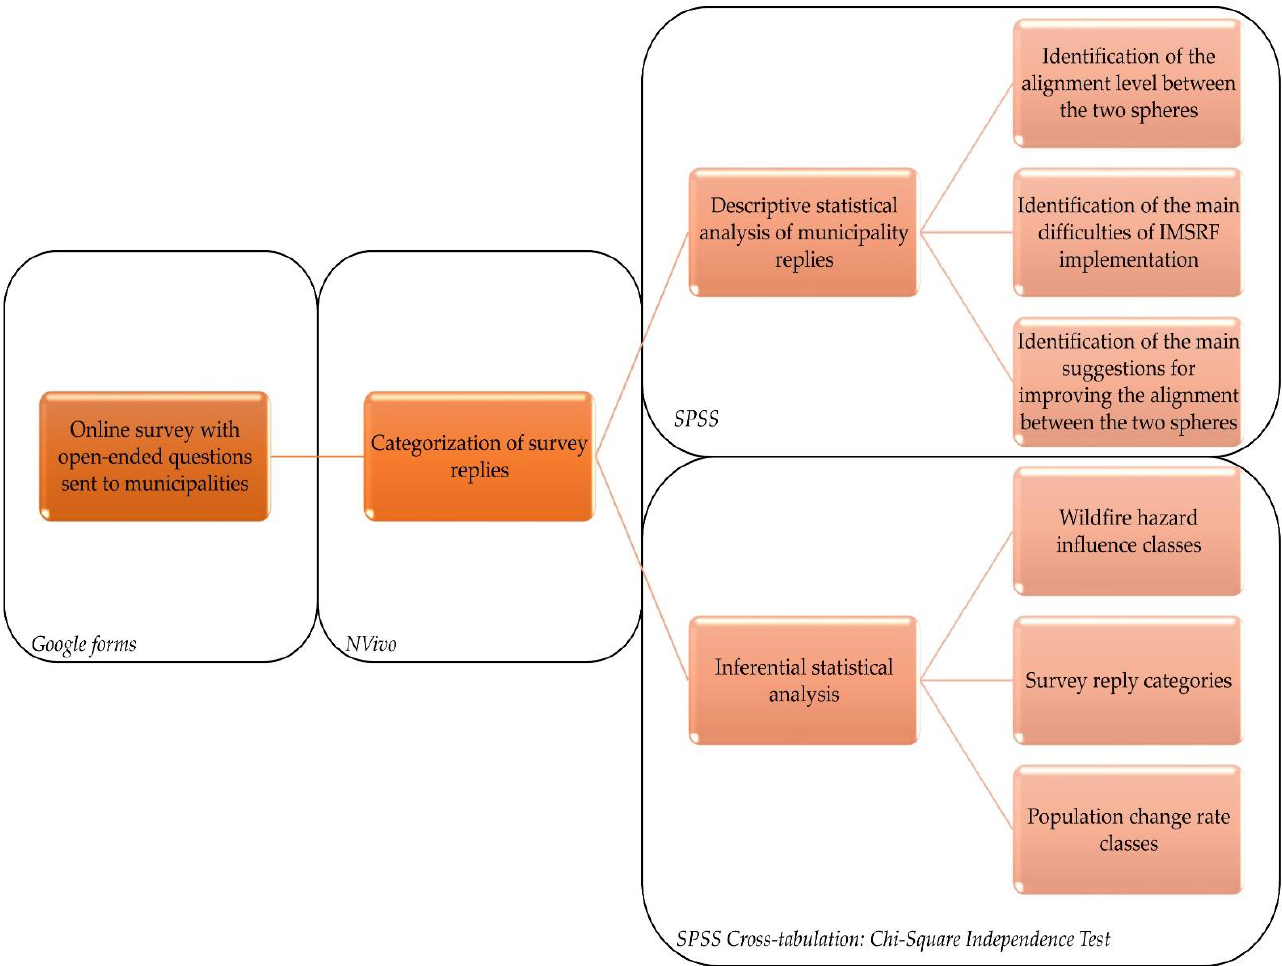
Figure 2. Applied methodological process .